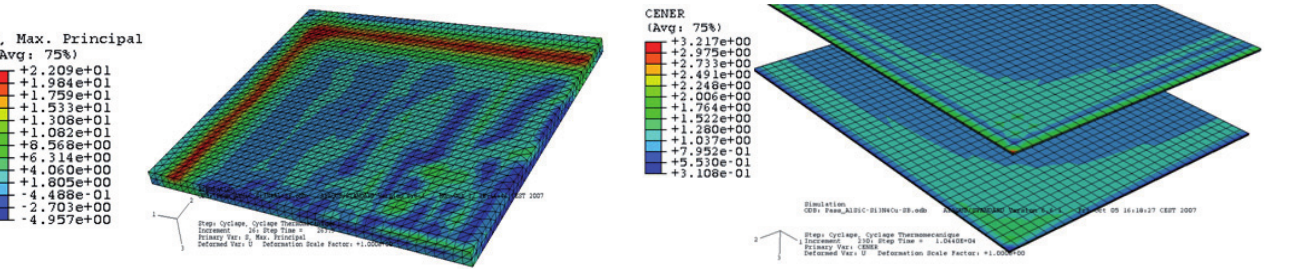
Fig. 18. ISED distribution in base plate solder after thermal cycling (mJ/mm 3 ).